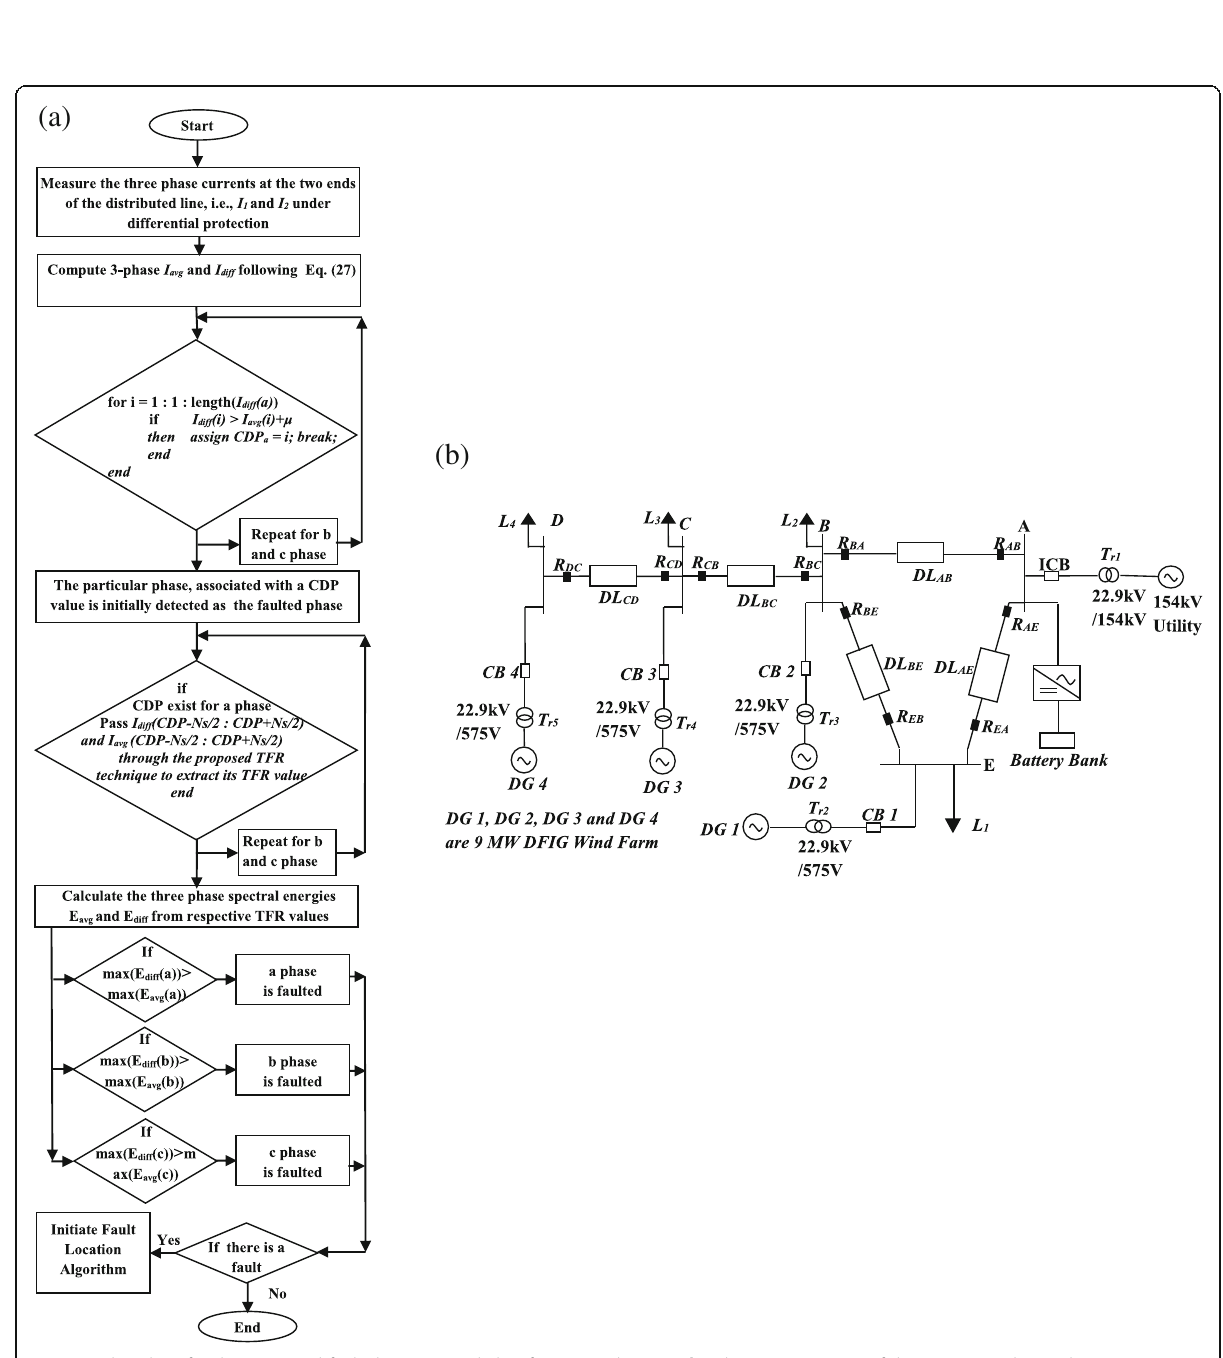
Fig. 1 a Flowchart for the proposed fault detection and classification techniques. b Schematic Diagram of the System under